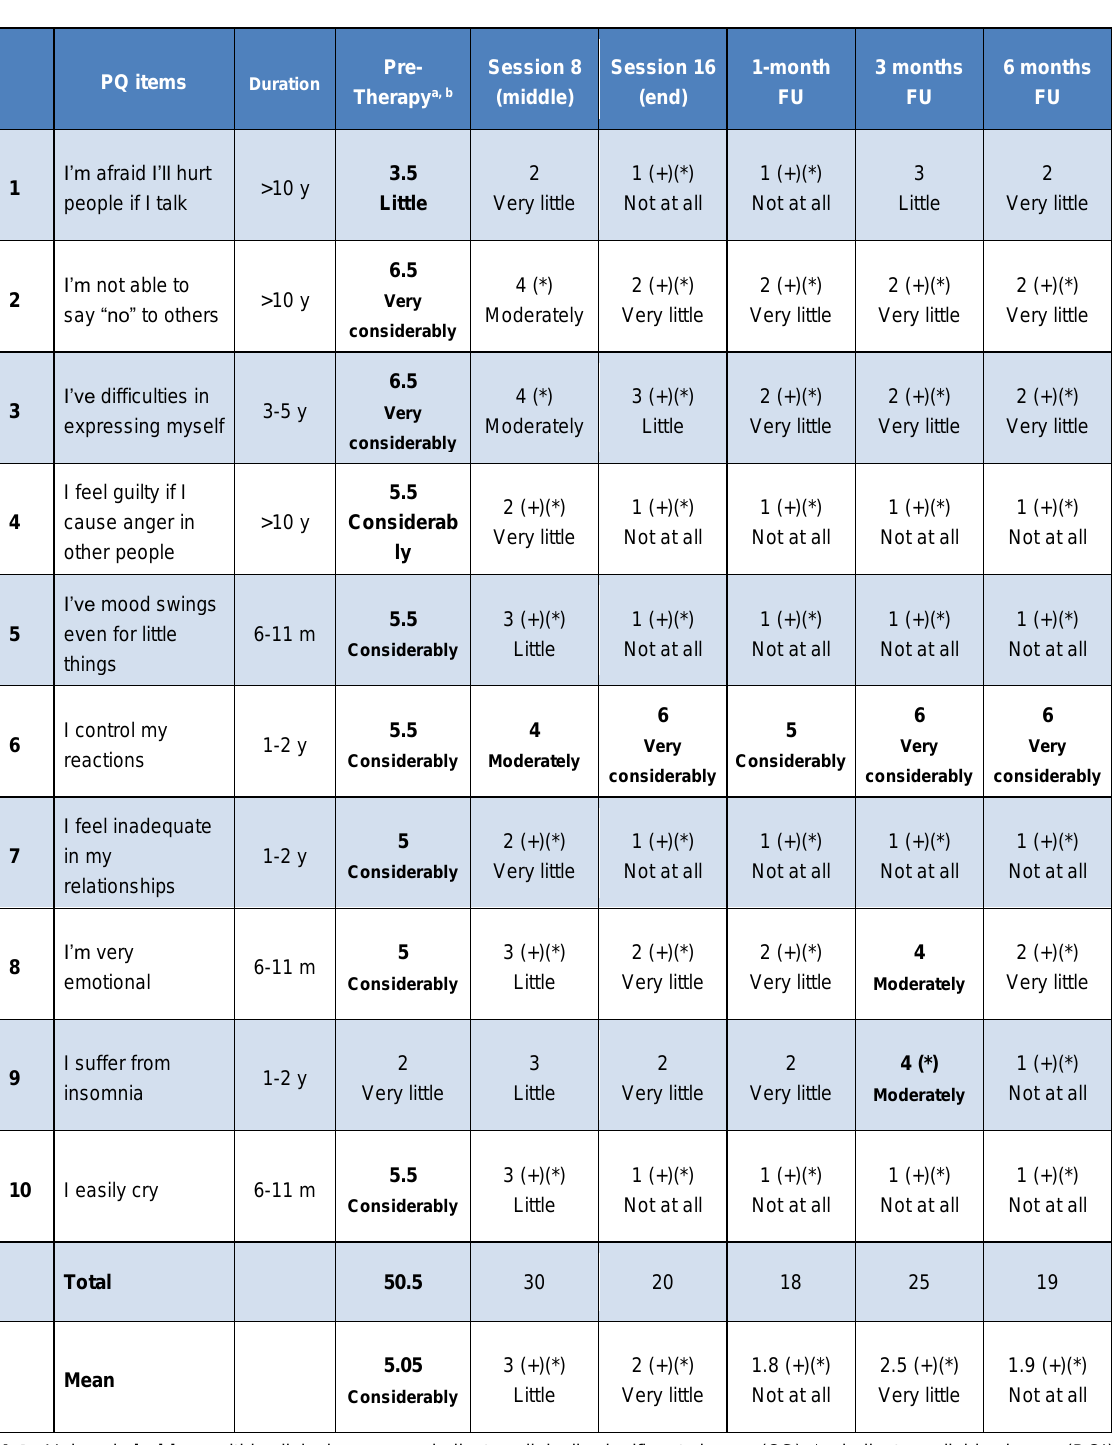
Table 2: Margherita’s personal problems (PQ), duration and